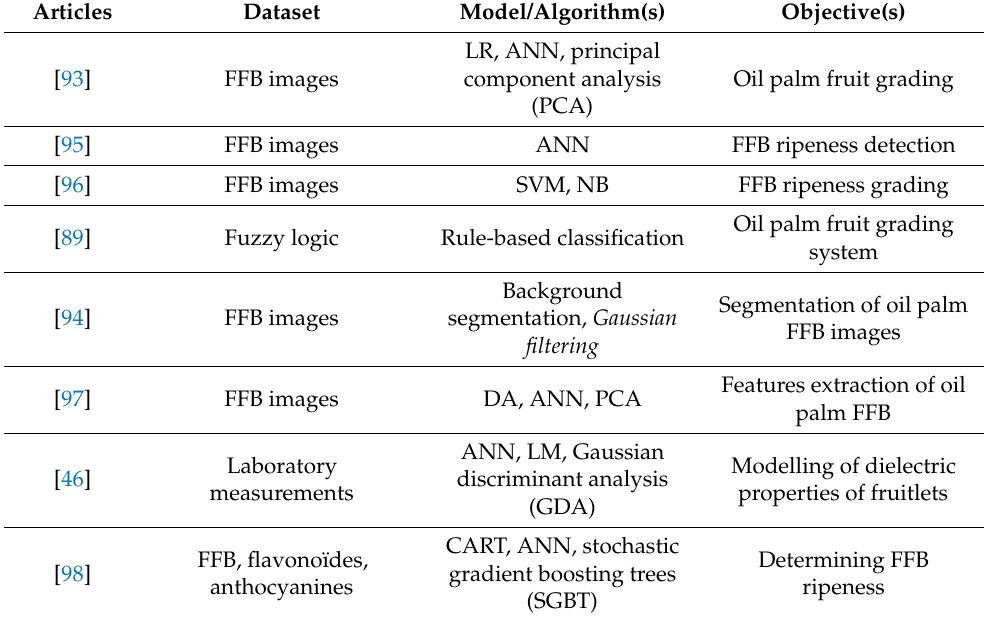
Table 7. Oil palm fruit